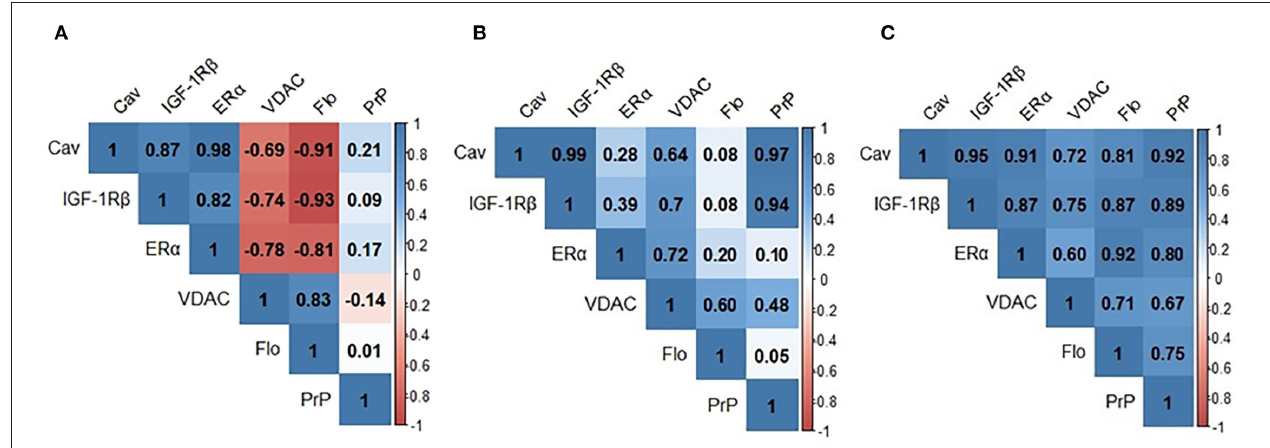
FIGURE 2 | Pearson’s correlation matrixes for signalosome proteins in the CSF of HC (A) SMC (B) and MCI (C) groups. Blue scale is used for positive correlations and red scale for negative correlations. Cav, caveolin; IGF-1R β , Insulin-like growth factor-1 receptor β ; VDAC, voltage dependent anion channel; Flo, flotillin; PrP, Prion